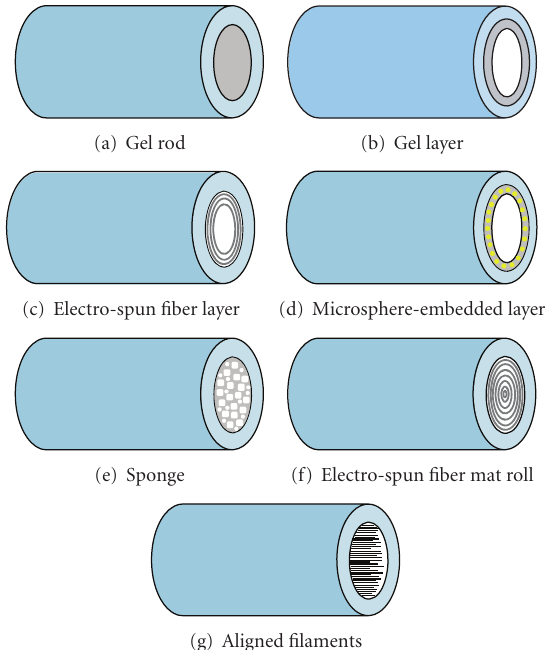
Figure 2: Forms of luminal fillers in polymer nerve